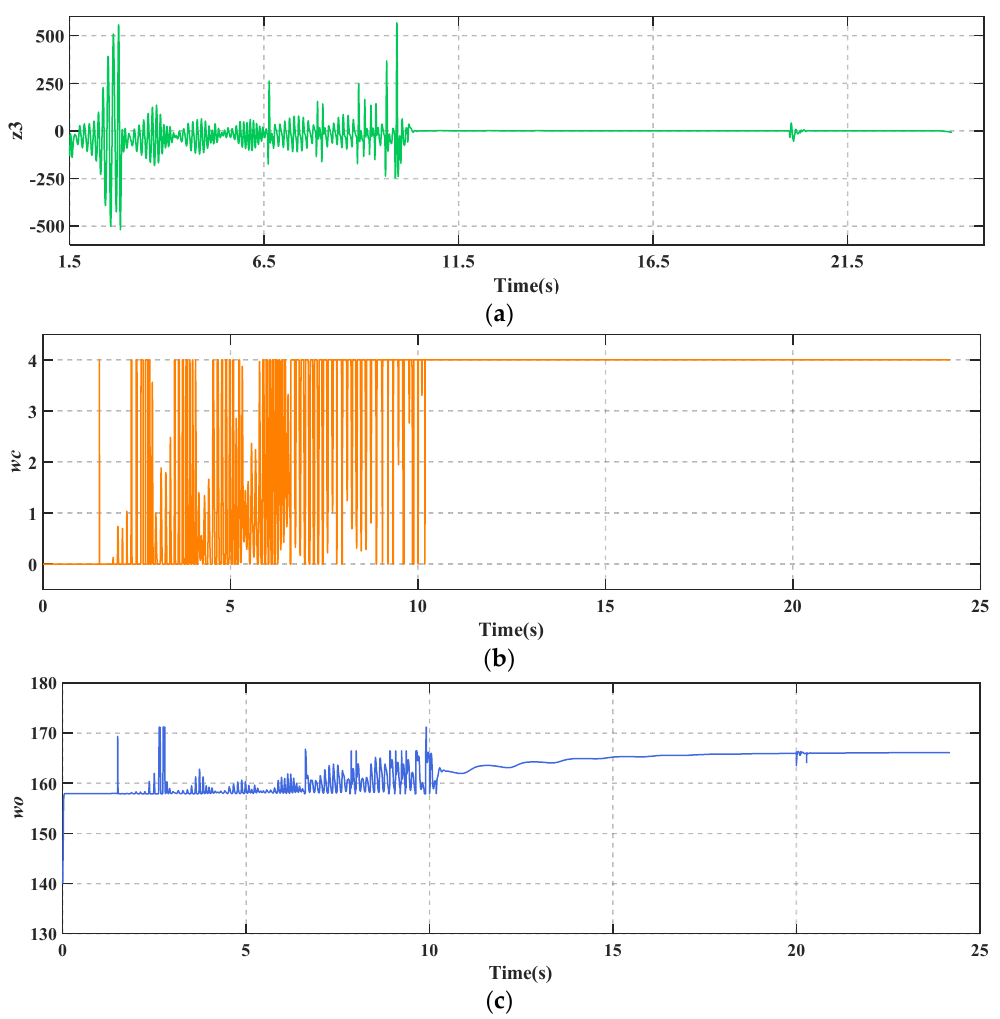
ω ; ( c ) observer bandwidth